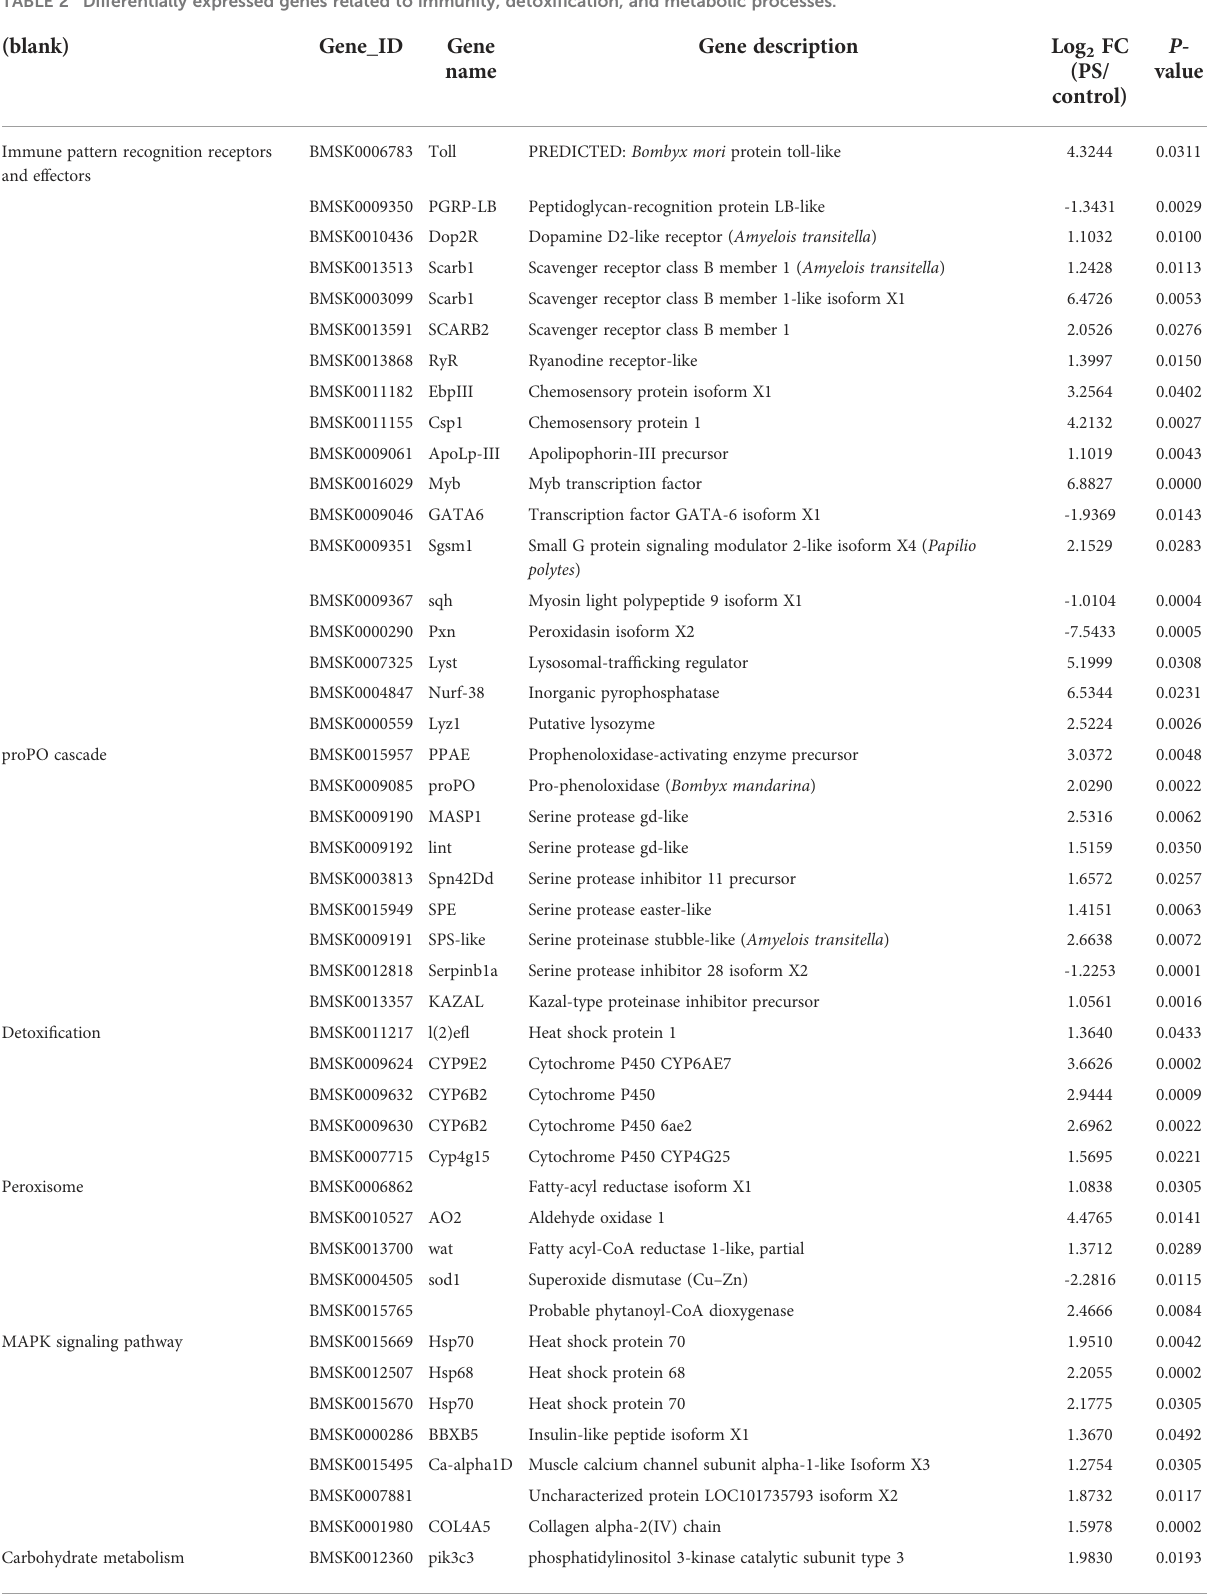
TABLE 2 Differentially expressed genes related to immunity, detoxi fi cation, and metabolic